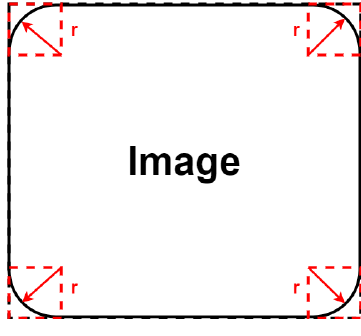
Figure 6. Tilting image with radius r .